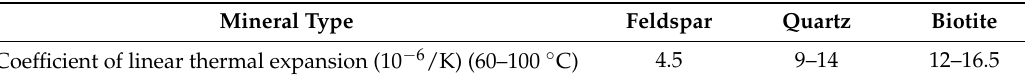
Table 2. Thermal expansion coefficients of minerals [12].